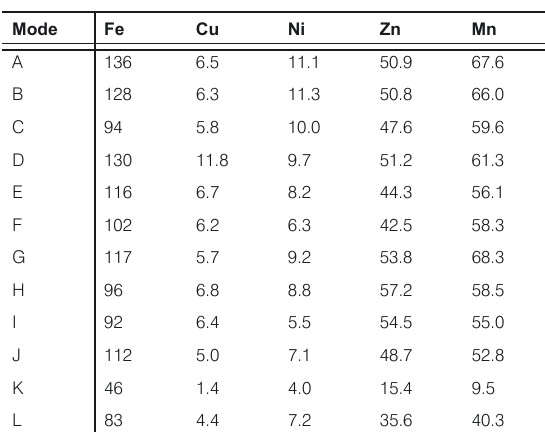
Table 2. The mean content [ m g g -1 ] of investigated metals in Viscum album samples, determined with 12 mineraliza- tion modes